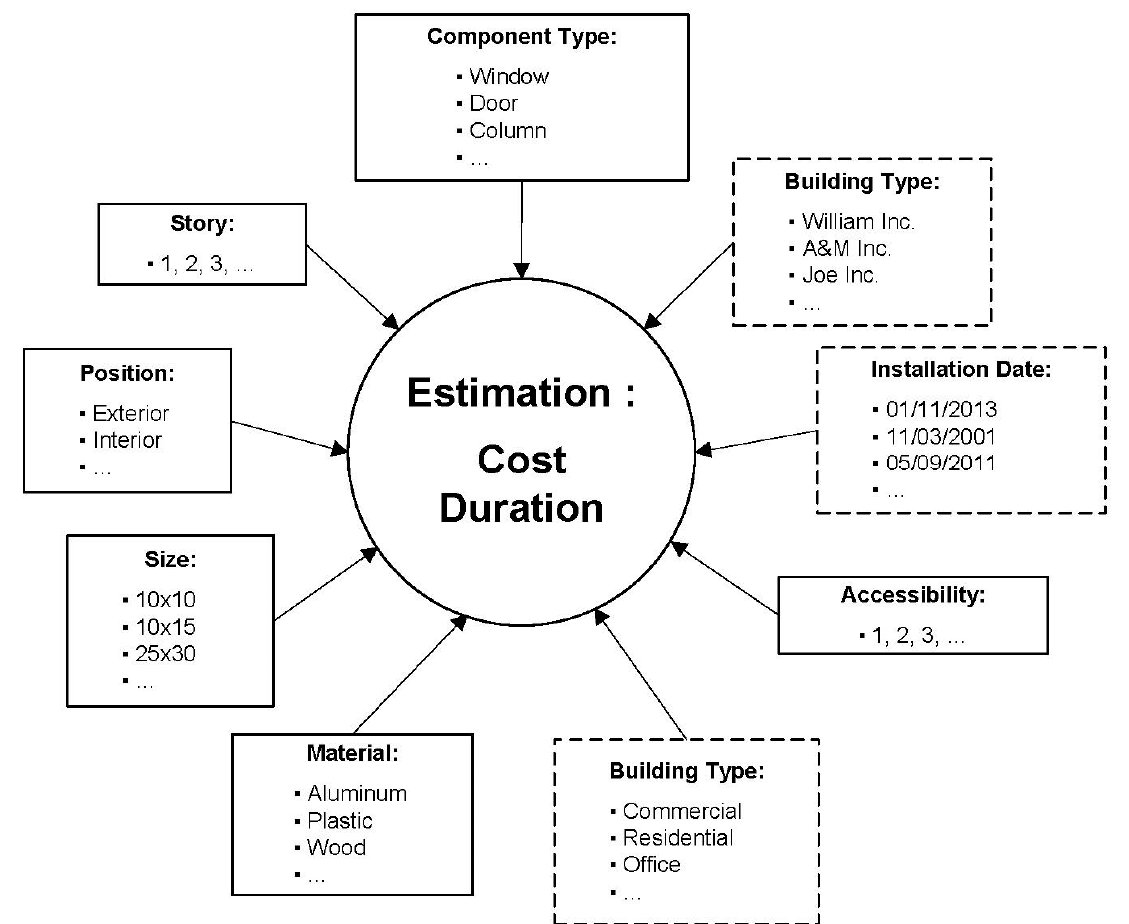
Figure 2. Factors influencing cost and duration estimation.